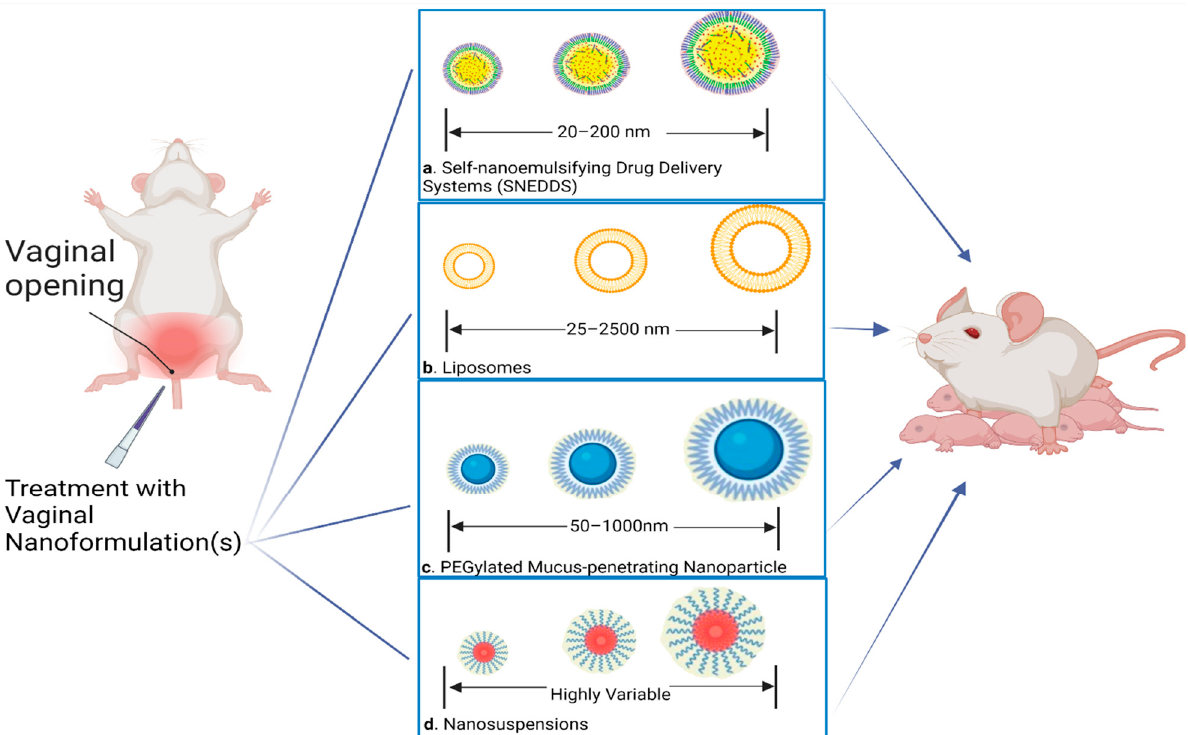
Figure 2. Schematic overview of different nanoparticle platforms that have been studied for their ability to improve drug delivery to the female reproductive tract and reduce the incidence of PTB.